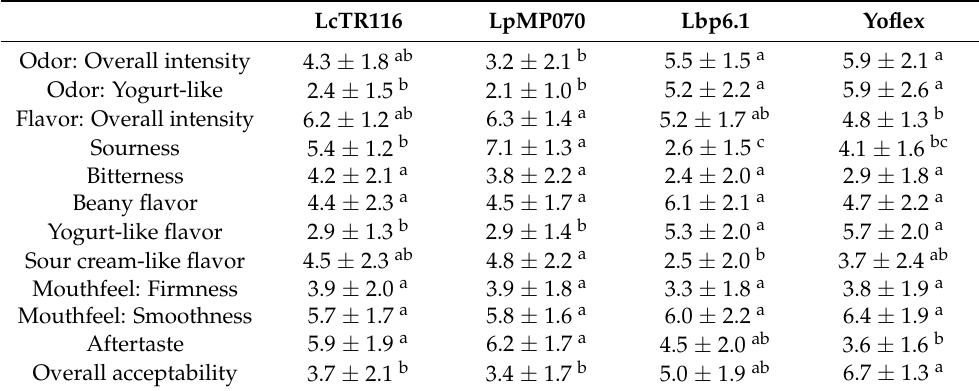
Table 7. Results of the sensory analysis of the fermented